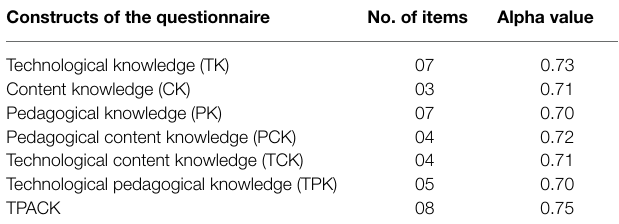
TABLE 3 | Reliability evaluation.